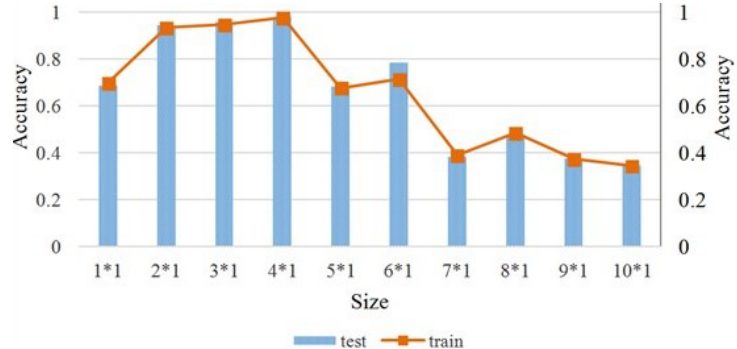
Figure 6. Accuracy statistics at different compression sizes.